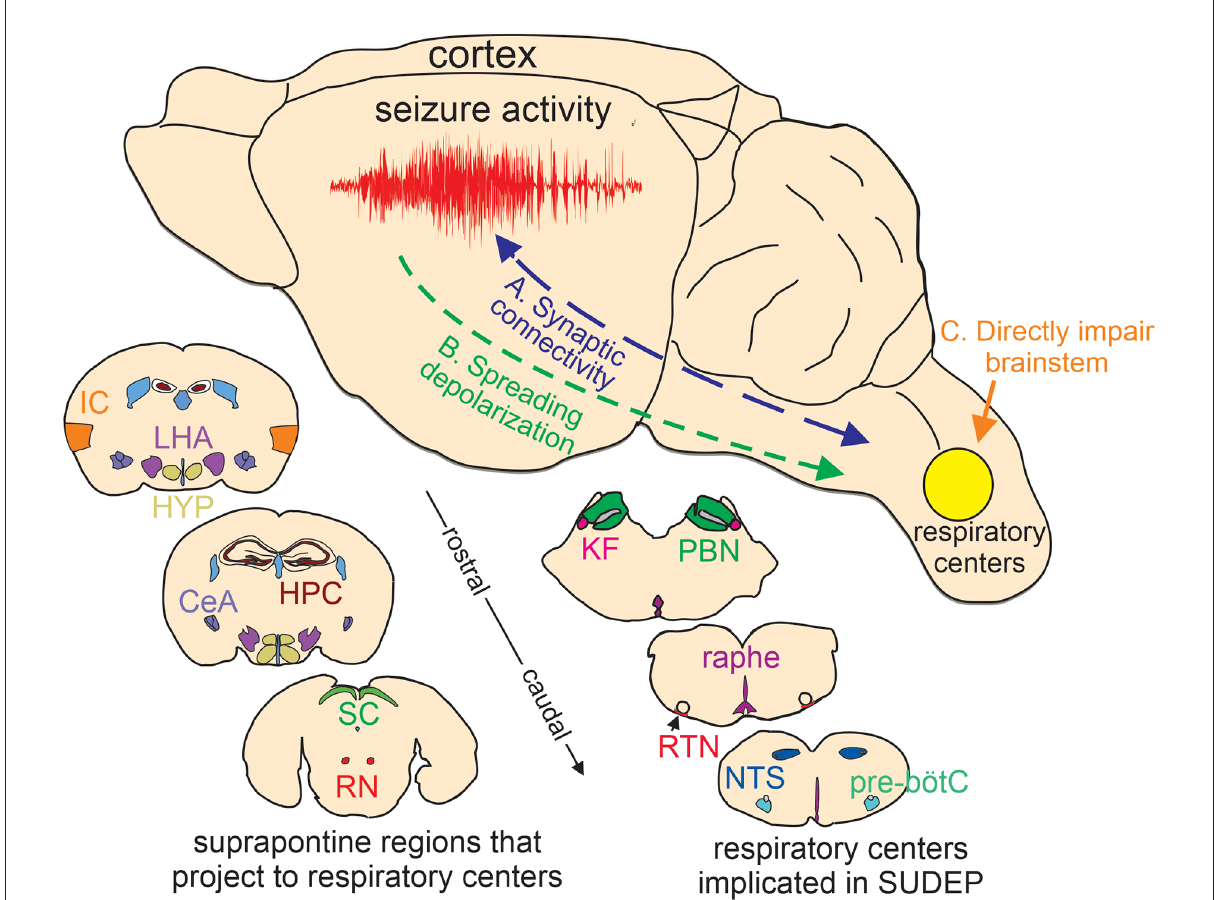
FIGURE1 Putative basis of brainstem dysfunction in epilepsy. (A) Cortical-brainstem connectivity provides an anatomical basis for seizure propagation to the brainstem. Likewise, brainstem-cortical projections have been shown to synchronize cortical network activity and so may influence seizure propensity. (B) Spreading depolarization can propagate through contiguous tissue and if it reaches the brainstem will likely result in respiratory failure. (C) certain epilepsy-associated ion channel mutations are expressed in the brainstem where they directly impair respiratory function. Lower insets, cartoon coronal sections show the relative location of suprapontine regions that project to brainstem respiratory centers implicated in SUDEP (Harper et al., 1998; McKay et al., 2003; Rosin et al., 2006; Yang et al., 2020; Trevizan-Baú et al., 2021; Feinstein et al., 2022; Leitner et al., 2022). IC, insular cortex; LHA, lateral hypothalamus; HYP, hypothalamus; CeA, central amygdala nucleus; SC, superior colliculus; RN, red nucleus; KF, kölliker-fuse; PBN, parabrachial nuclei; raphe, medullary raphe nucleus; RTN, retrotrapezoid nucleus; NTS, nucleus of the